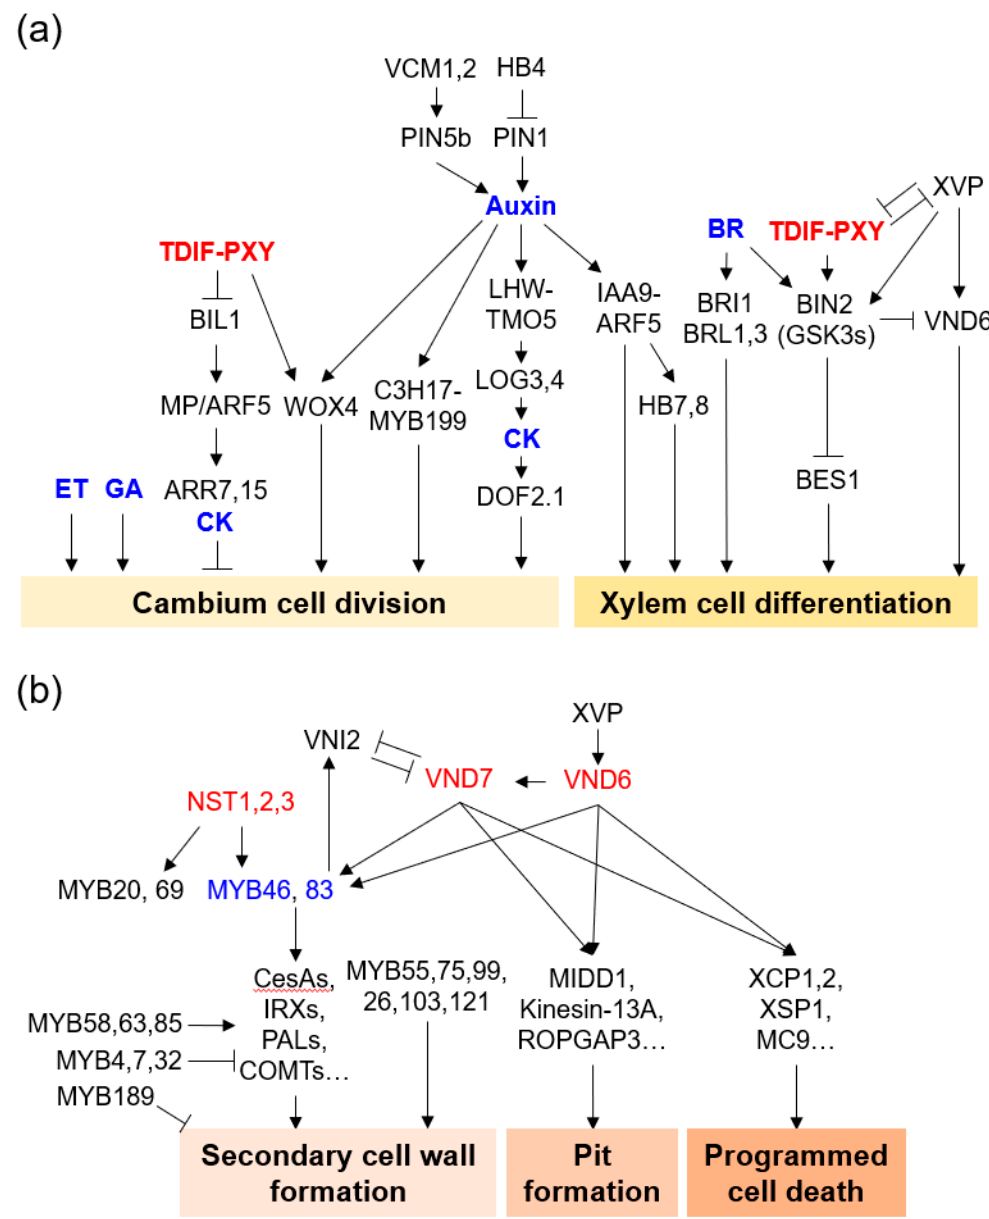
Figure 2. Molecular regulatory network of xylem cell formation. ( a ) Vascular cambium cell division and xylem cell differentiation. ( b ) Secondary cell wall formation, pit formation, and programmed cell death in xylem cell formation. Representative genes were depicted with hormones (blue). Genes with essential roles are described in the text.